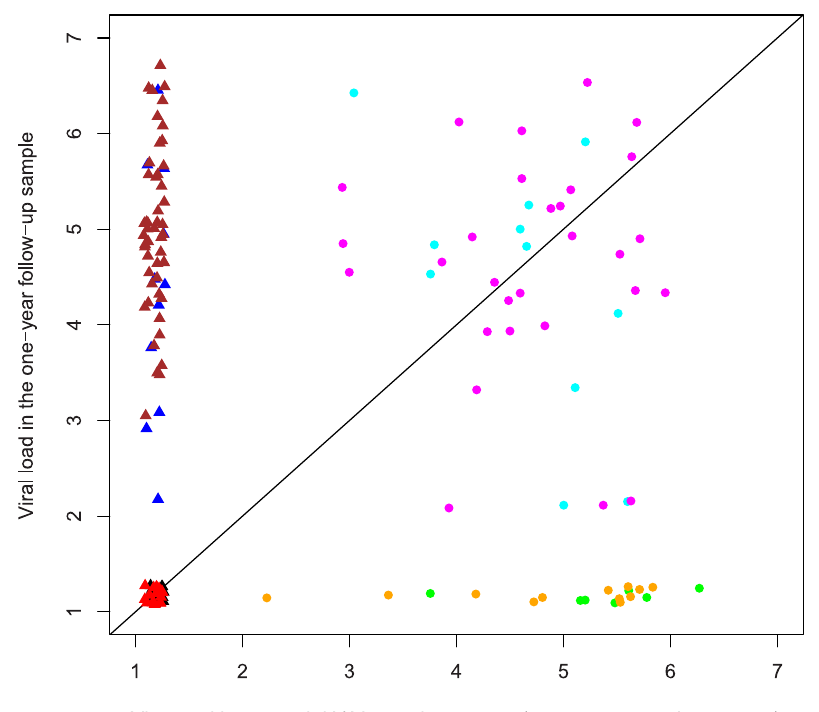
Figure 3. Pairwise comparison of individual viral loads in the pre-seroconversion versus one year follow-up samples. Methodology as in figure 2. Viral load was significantly lower or equal to in the follow-up sample (p , 0.001, CI 0.66–0.81) for the whole group (p , 0.001, CI 0.67–0.82 when excluding group G). For the subgroup of pre-seroconversion viremic values were p=0.04, CI 0.24–0.49 (p=0.007, CI 0.18–0.45 when excluding group G).